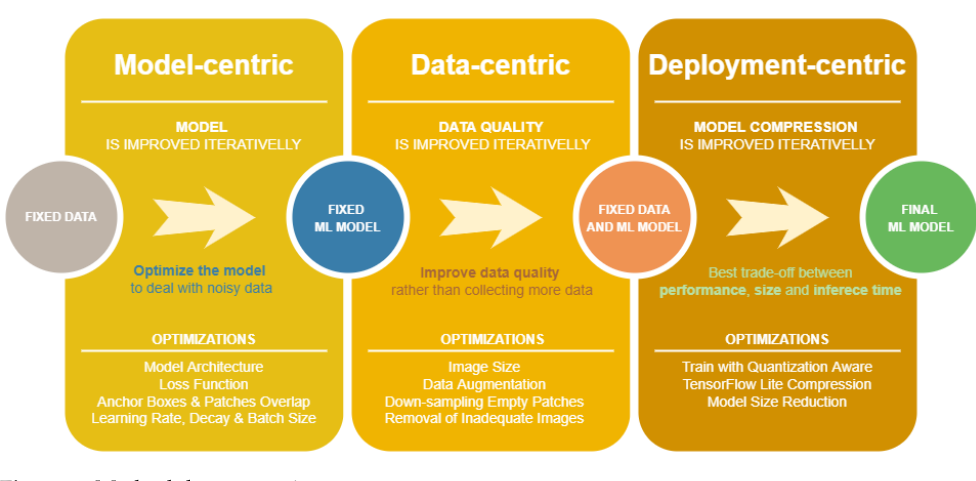
Figure 4. Methodology